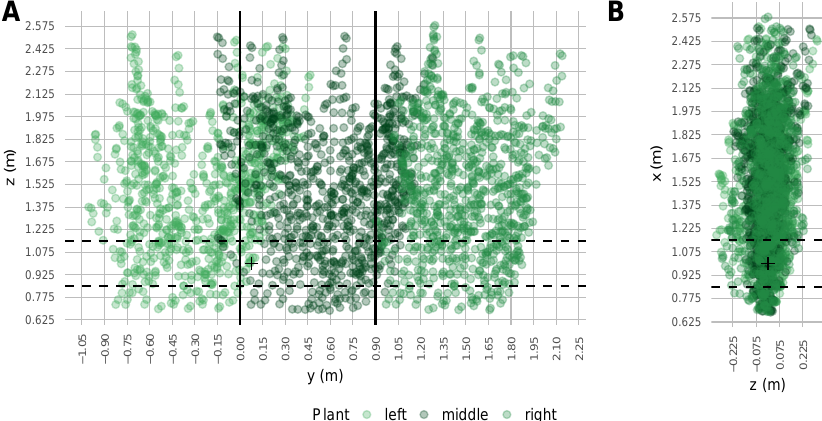
Figure 10. Canopy representation by leaf location points of three simulation plants. Calculations of leaf area density are conducted using the central zone (vertical solid lines, ∆ y trunk = 0.9m (trunk distance)), i.e., a representative canopy section divided into cubes of 0.003375m 3 ( a cube = 0.15m) (dashed line: bunch zone (0.85m ≥ z ≥ 1.15m); + : centre point of initial cube): ( A ) side view; and ( B ) backward